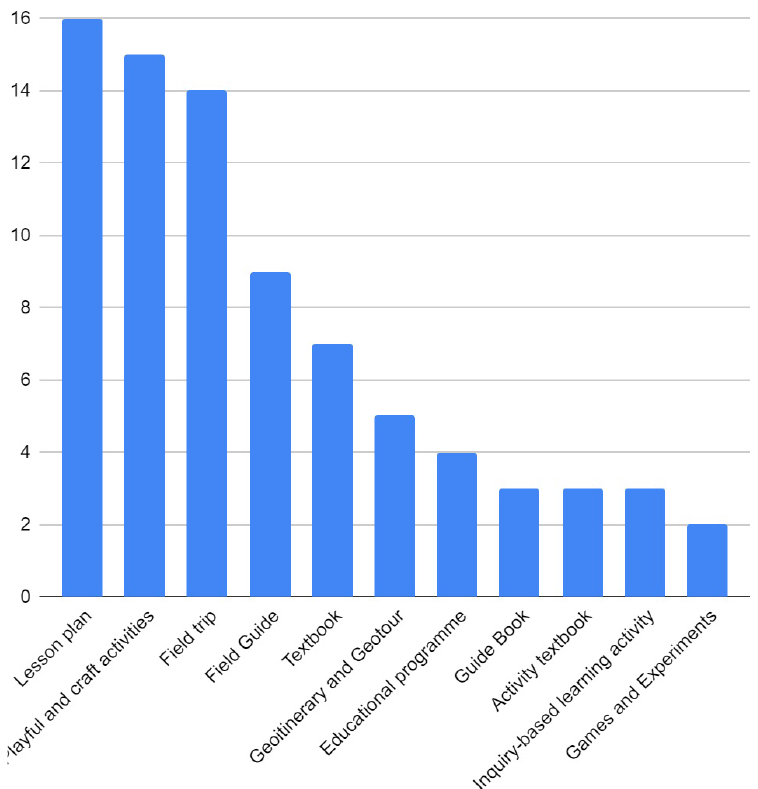
Figure 3. Quantity and typology of activities found on UGGp websites.